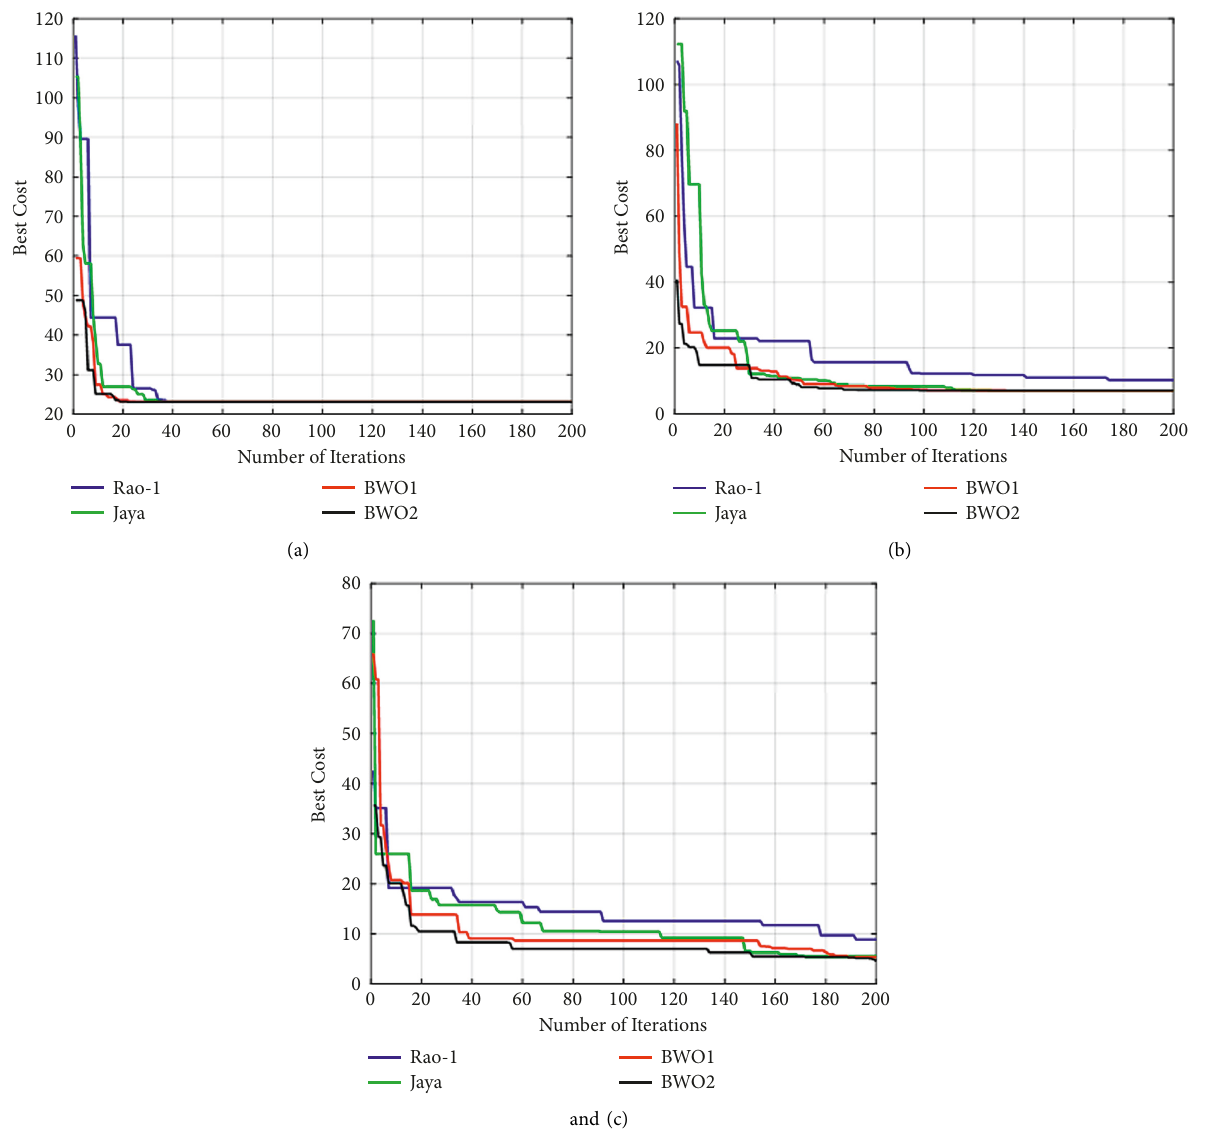
Figure 20: Convergence characteristics of Rao-1, Jaya, BWO-1, and BWO-2 for the 69-bus test system for simultaneous allocation of (a) 1DG and 1SC, (b) 2DGs and 2SCs, and (c) 3DGs and